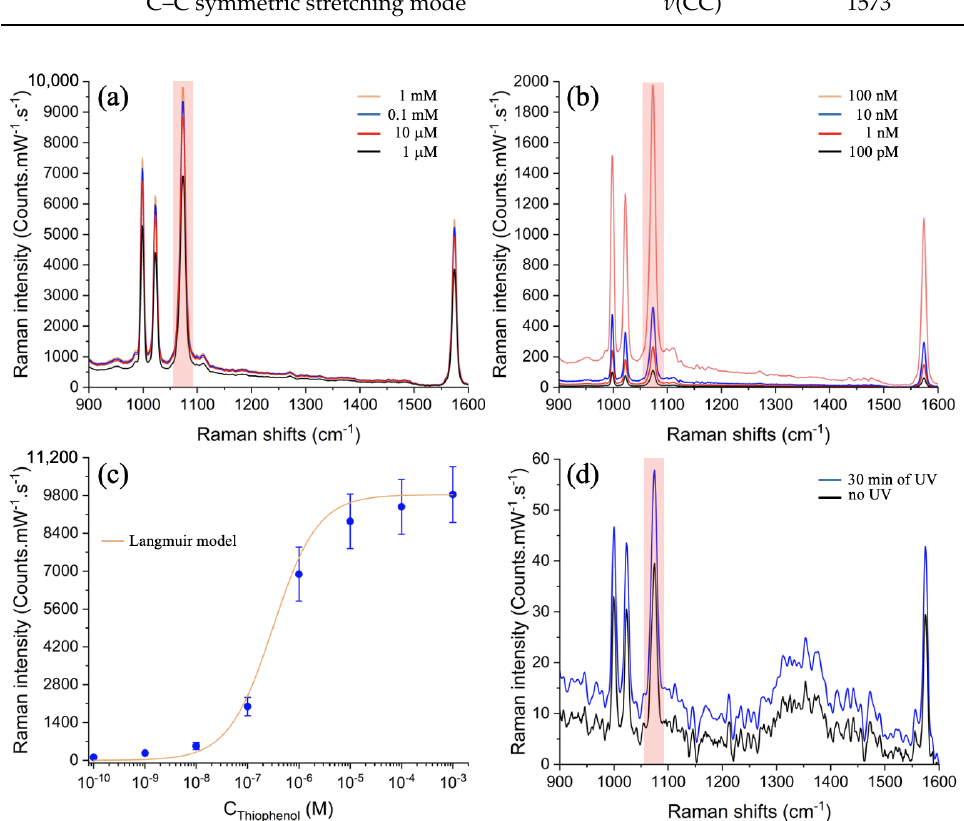
Figure 3. Raman (SERS + PIERS) spectra for the following thiophenol concentrations: ( a ) 1 mM (yellow color), 0.1 mM (blue color), 10 µ M (red color), 1 µ M (black color), and ( b ) 100 nM (orange color), 10 nM (blue color), 1 nM (red color), and 100 pM (black color). ( c ) Raman (SERS + PIERS) intensity as function of thiophenol concentration. Blue dots are the experimental data, and the orange fit curve is the Langmuir model. ( d ) Raman spectra of thiophenol (C = 1 M) obtained on ZnO film without Au nanoparticles serving as reference (in blue, with an UV-irradiation time of 30 min and in black without UV-irradiation). For all the Raman spectra of this figure, the vibration mode at 1073 cm − 1 chosen for the study is encapsulated in the red